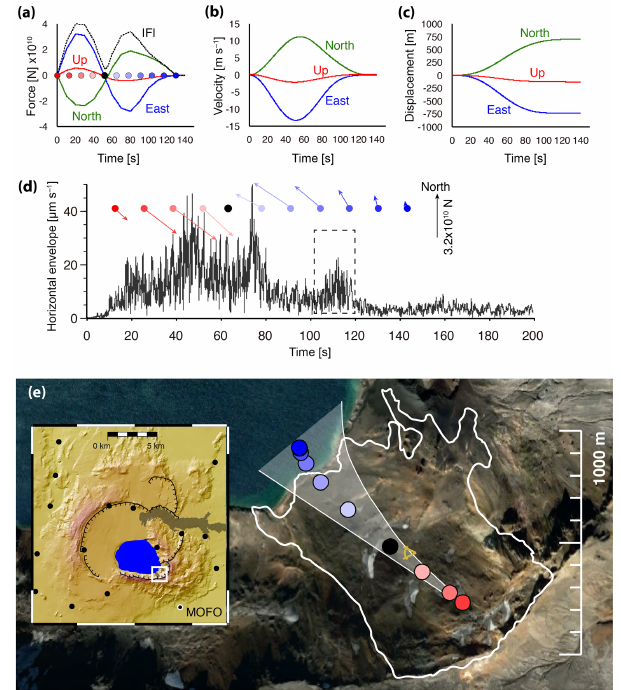
Figure 5. Results of the landslide force history inversion. (a) Force–time evolution, (b) velocity–time, and (c) displacement– time plots for the north, east, and upwards components of the load- ing force. Red circles in panels (a) , (d) , and (e) mark the acceler- ation phase, and the black circle is the transition to the decelera- tion phase (blue circles) of the landslide motion. (d) Time evolu- tion of the landslide acceleration and deceleration with horizontal force vectors (arrows) for each time step (north is up). Horizon- tal envelope function of the MOFO station (see inset in panel e for location), computed with the root mean square amplitudes of the horizontal component waveforms, filtered between 1 and 45Hz for comparison. The dashed box highlights the late-arriving seis- mic signals. The start of the x axis is at 23:24:05UTC. (e) Path of the landslide bulk mass from the landslide force history inversion of the seismic waveforms between 0.02 and 0.08Hz. Shaded white area is the range of the inversion results with different frequencies of the band-pass filter (0.02–0.05, 0.02–0.08, 0.04–0.08Hz). The white line is the outline of the landslide source area plotted on top of a Google Earth image taken on 7 August 2012. The yellow eye looking towards the west is the location of the photography pre- sented in Fig. 3. The white square in the inset shows the location of the main